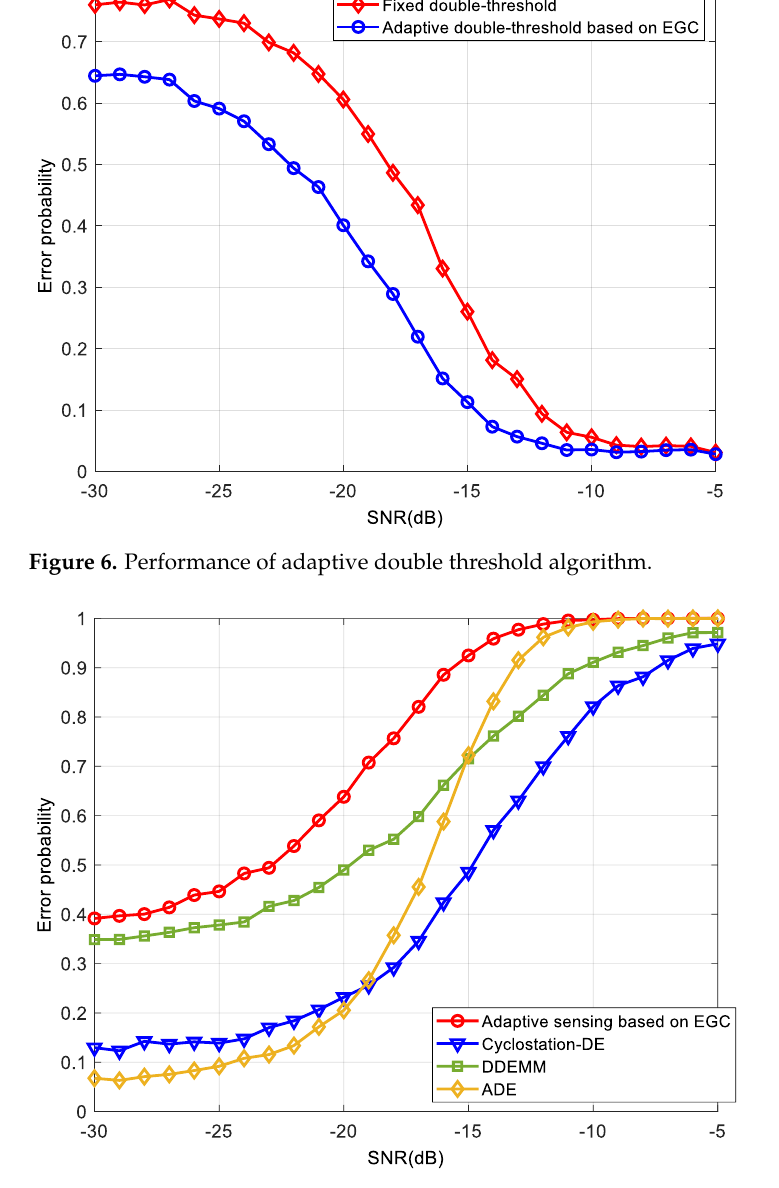
Figure 7. Performance of dual threshold cooperative sensing algorithm based on EGC.